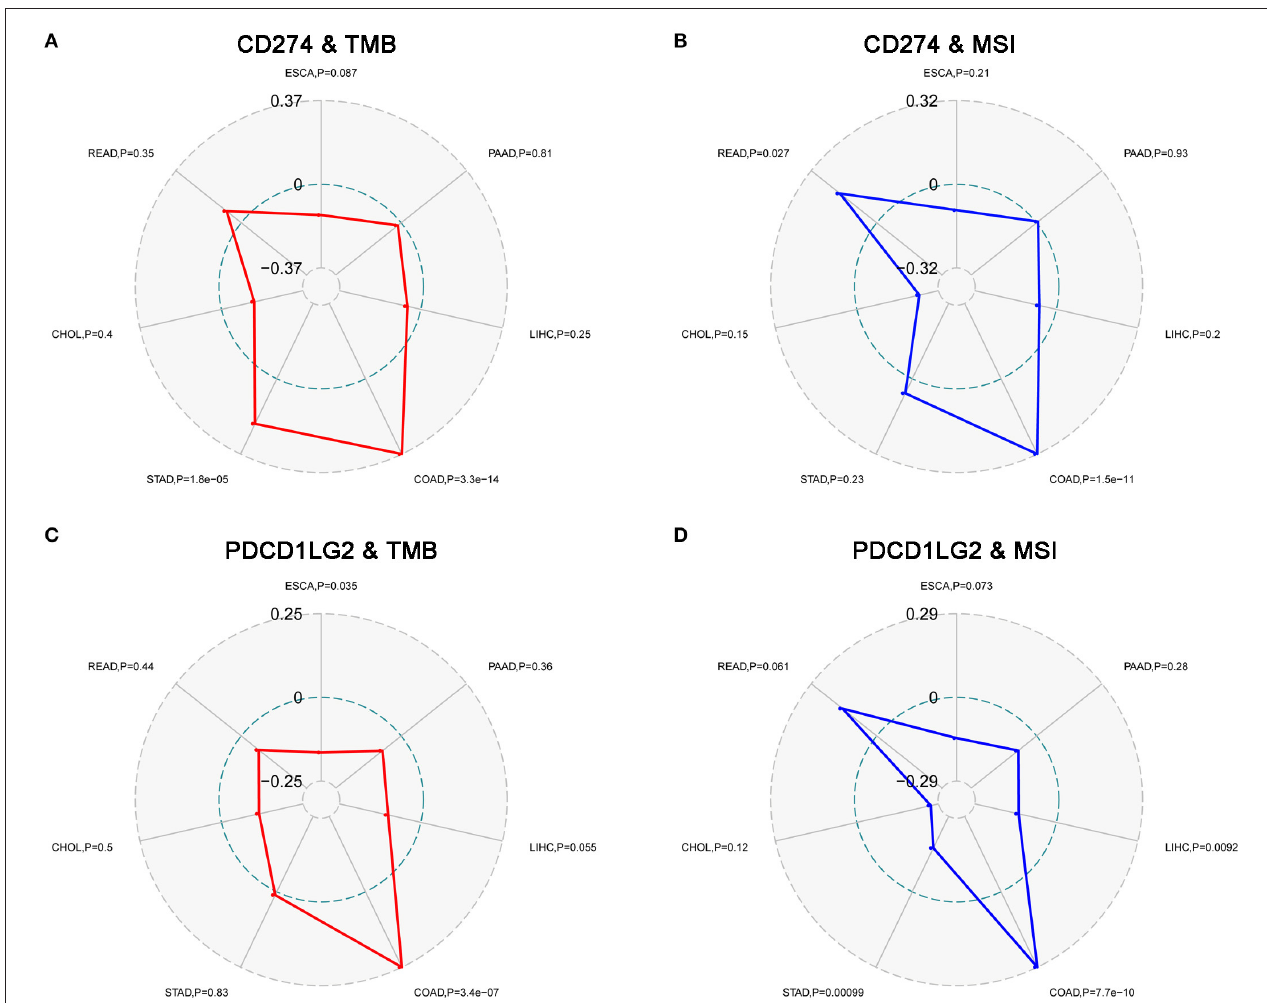
FIGURE 5 | CD274/PDCD1LG2 expression is correlated with tumor mutation burden (TMB) and microsatellite instability (MSI). (A) Radar chart displaying a correlation between CD274 and TMB across seven cancers. Red line representing the Spearman correlation coefficient. (B) Radar chart displaying a correlation between CD274 and MSI. Blue line representing the Spearman correlation coefficient. (C) PDCD1LG2 expression and TMB. (D) PDCD1LG2 and MSI.